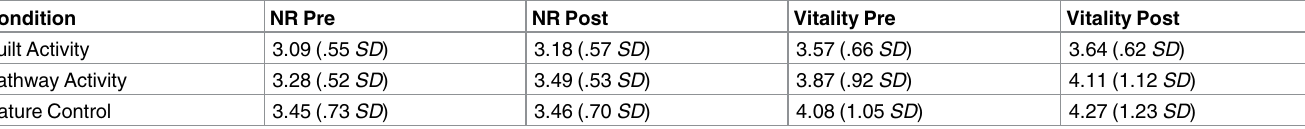
Table 17. Means and standard deviations of the three experimental conditions.